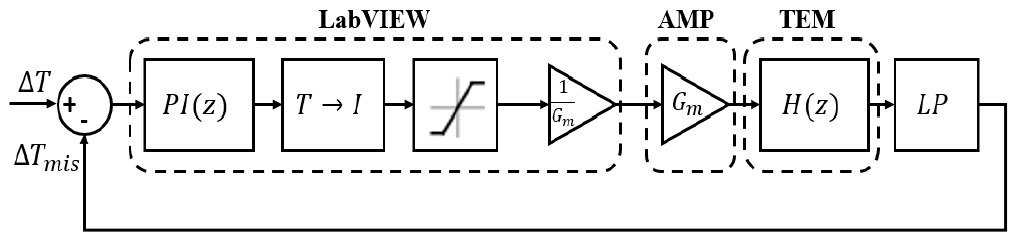
Figure 4. TEM control loop.